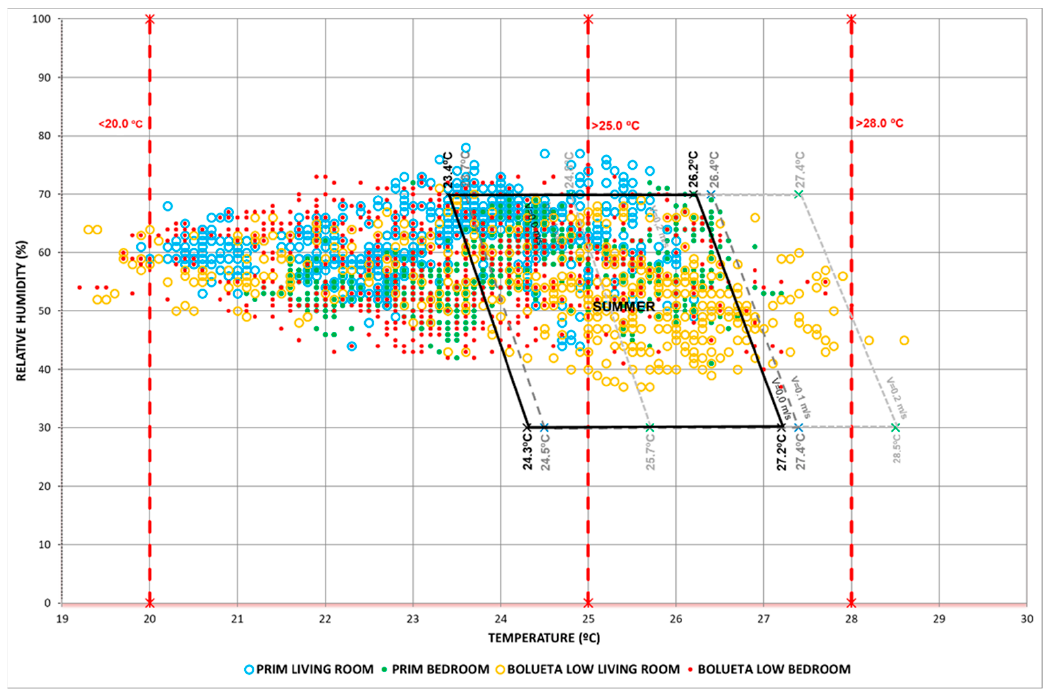
Figure 23. Summer comfort diagram comparison for both Prim and Bolueta Low case studies. Sep- tember 2020. Source: authors.